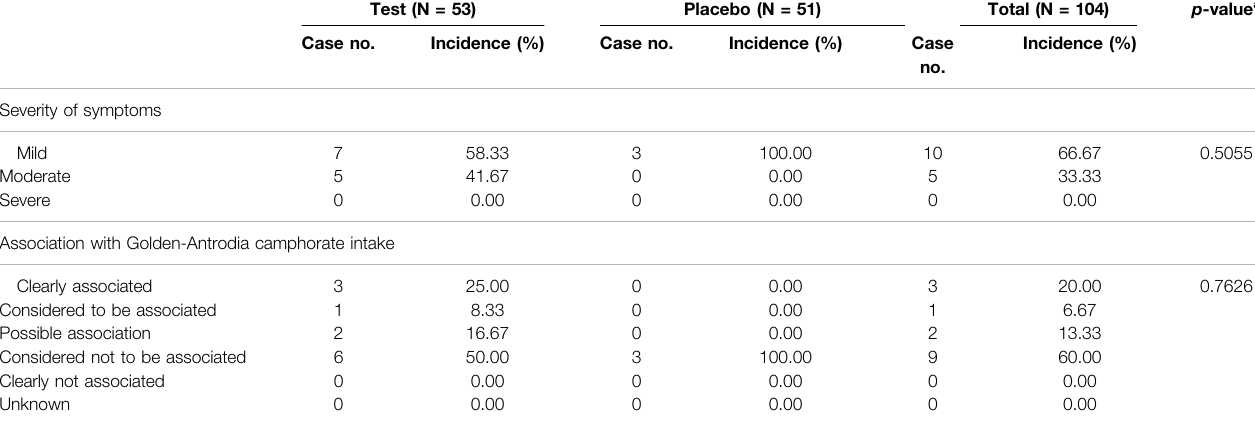
TABLE 8 | The severity of adverse events and their association with consumption of Golden- Antrodia Camphorata (Safety set). Test (N = 53) Placebo (N = 51) Case